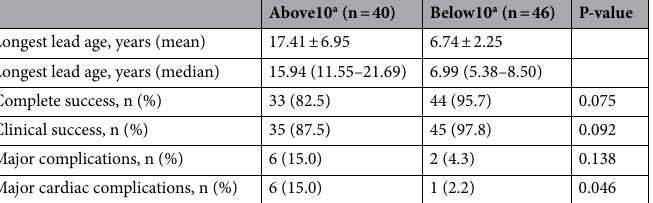
Table 4. Procedural outcome according to longest lead age. a Indicates patients with longest lead age > 10 years and ≤ 10 years, respectively.